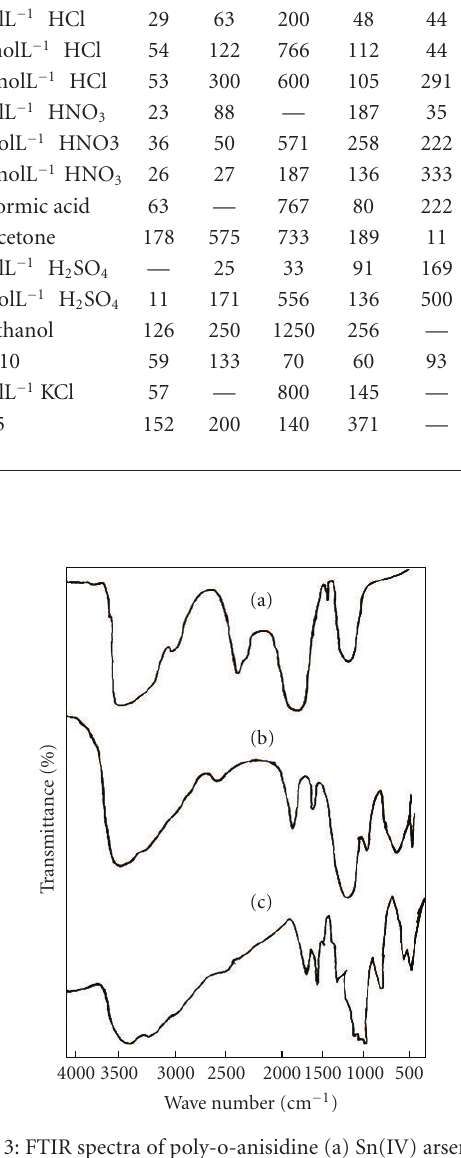
Figure 6 . Suitable concentrations were chosen for sloping portion of the linear curve, and the slope value is found to be 32.8 mV. The limit of detection is determined from the intersection of the two extrapolated segments of the calibration graph as discussed elsewhere [19], it was found to be 1 × 10 − 6 molL − 1 , and thus the working concentration range is found to be 1 × 10 − 1 molL − 1 to 1 × 10 − 6 molL − 1 for Pb 2+ ions. Below 1 × 10 − 6 molL − 1 non linear